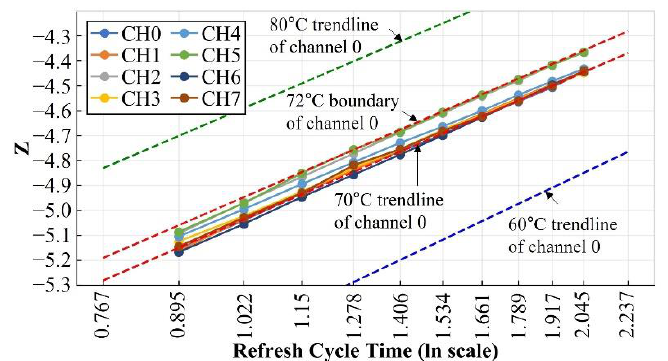
Figure 20. Z-value plots with varying RCT in all the channels with T L fixed at 70 °C, boundaries (red dashed lines), and Channel-0 trendlines at T L of 60 °C and 80 °C (green and blue dashed lines). The red dashed lines show the boundaries of all the channels concerning Channel-0 error counts at a T L of 70 °C. The lower red dashed line represents the trend of error counts at 70 °C. The upper red dashed line specifies the upper boundary to enclose all the channels’ Z -values; the boundary is located at the two-tenth point between 70 °C and 80 °C.